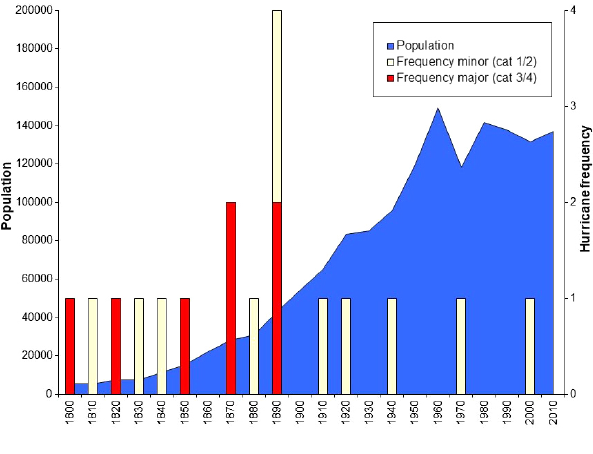
Fig. 3 . Frequency of major and minor hurricanes that affected the City of Savannah up to 2000, compared to population